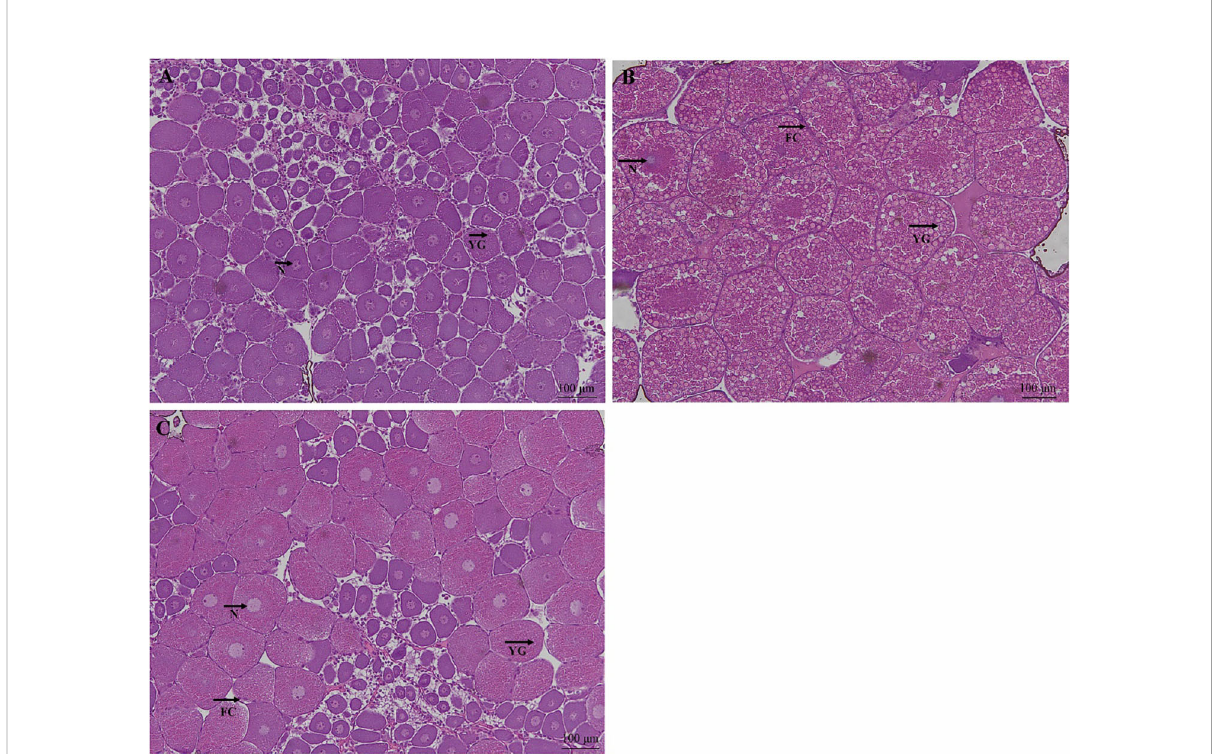
FIGURE 2 H&E staining of ovarian tissue from E. sinensis subjected to different levels of dietary CHO (means ± SEM, n = 4). Photomicrographs (10×) and scale bar (100 m m). (A) : crabs fed with 0% CHO diets; (B) : crabs fed with 0.4% CHO diets; (C) crabs fed with 1.6% CHO diets. N: nucleus; YG: yolk granule; FC: follicle